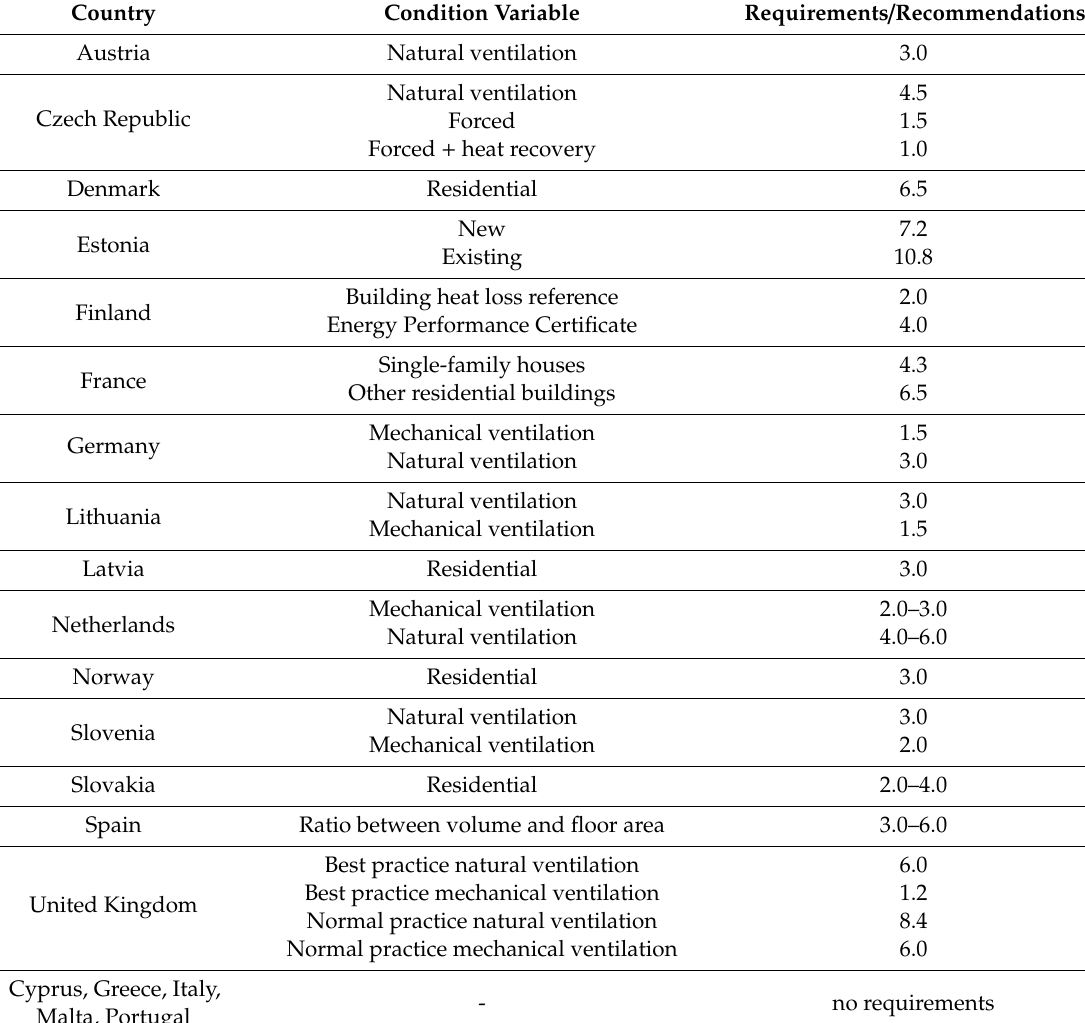
Table 2. Airtightness requirements / recommendations in several European countries normalized to ACH 50 (when needed)